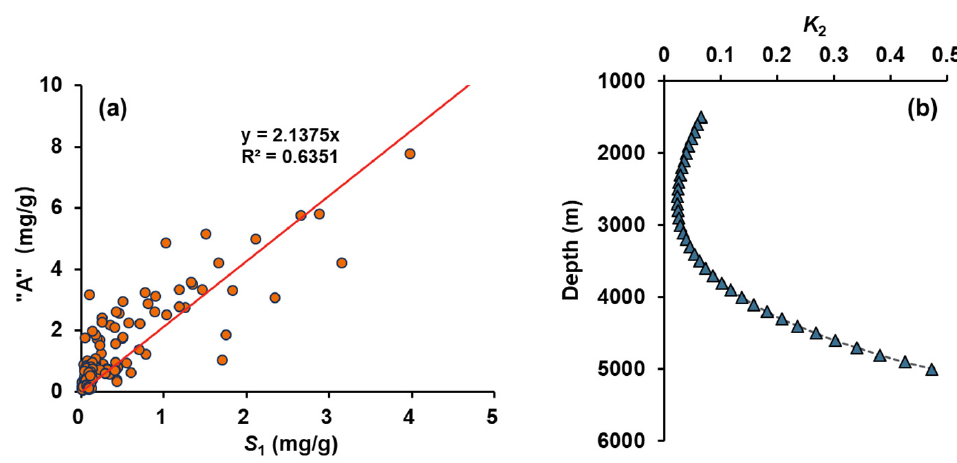
Figure 4. Relationships of chloroform bitumen “A” with S 1 ( a ), and burial depth with K 2 ( b ).